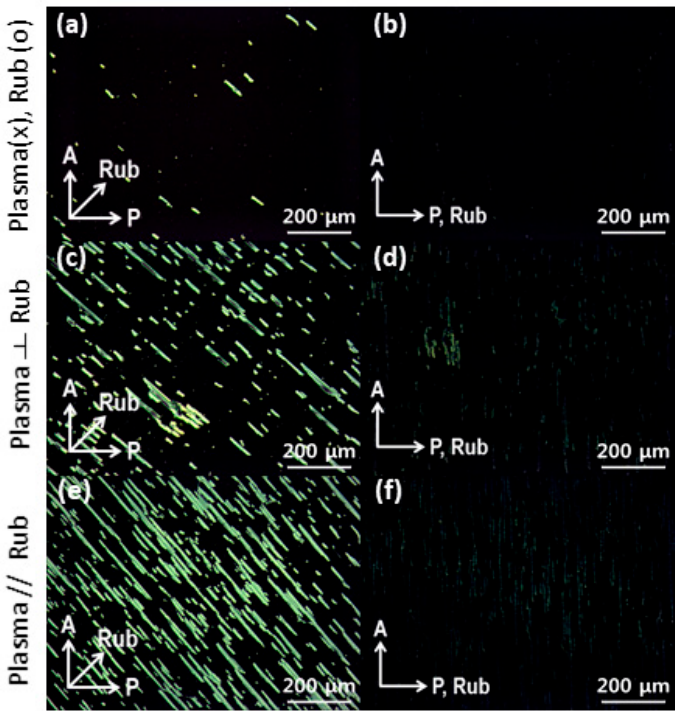
Figure 5. POM images of the HCM026 samples located between the crossed polarizers. PVA was used as an alignment layer. Plasma was not treated in ( a , b ). The plasma direction was perpendicular to the rubbing direction in ( c , d ), while it was parallel to the rubbing direction in ( e , f ). The rubbing directions of the samples were at 45° in ( a , c , d ) and 0° in ( b , d , f ).